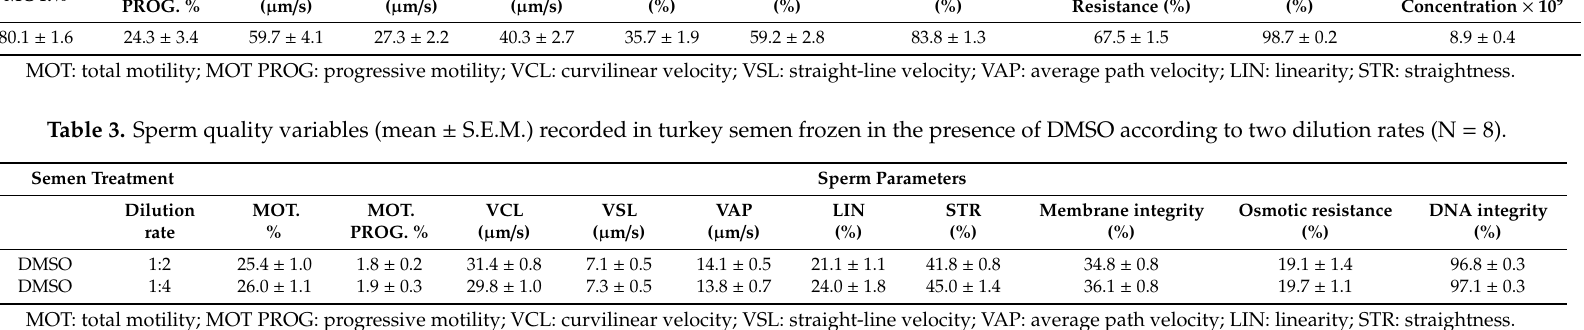
Table 2. Sperm quality parameters (mean ± S.E.M.) measured in freshly collected turkey semen (N = 8). MOT.%